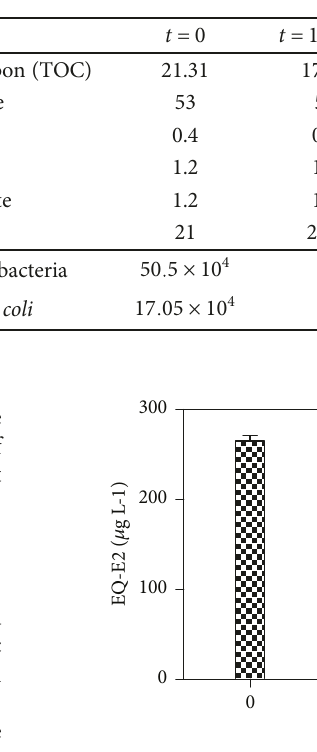
Table 1: Physical-chemical and microbiological evaluation during EDC photodegradation in WWTP by Cl/UVC. Initial EDC time: 90 minutes.